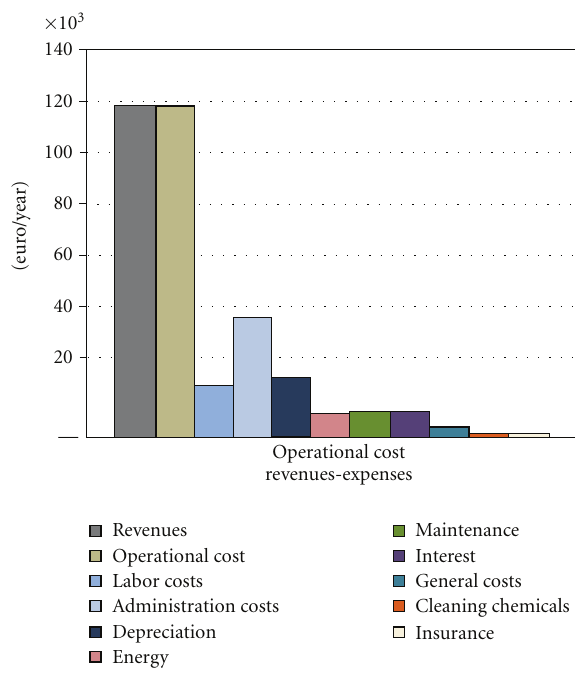
Figure 2: Cost-benefit analysis for a capacity of 50,000 t/yr. Figure 3: Cost-benefit analysis when the unit is working in a capacity of 2,800 t/yr (breakeven point).